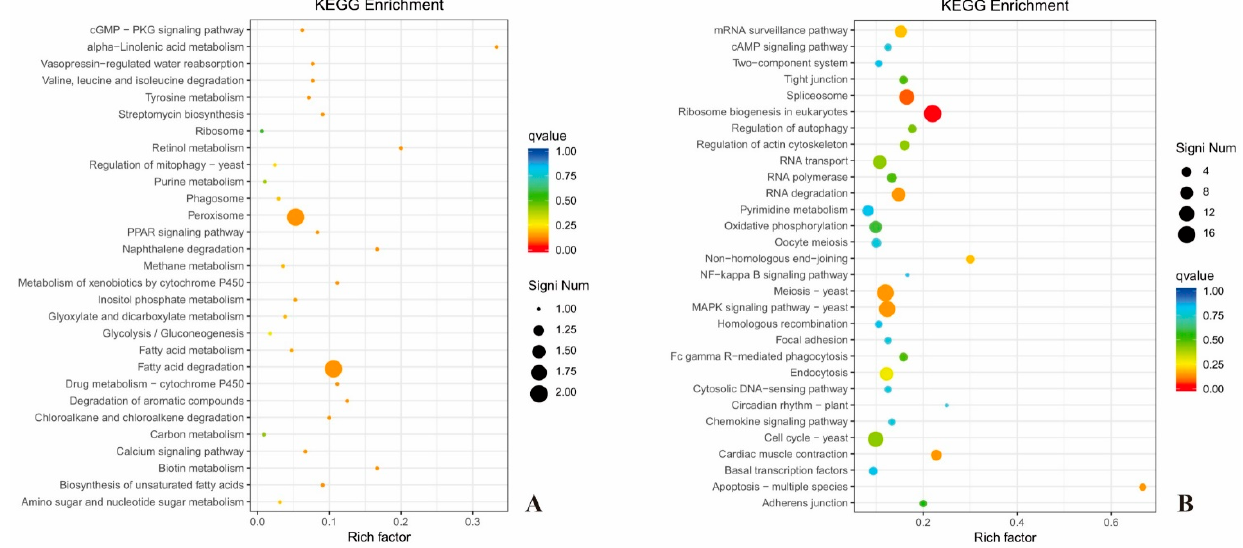
Figure 14. Enrichment analysis of up-regulated genes ( A ) and down-regulated genes ( B ) based on KEGG.